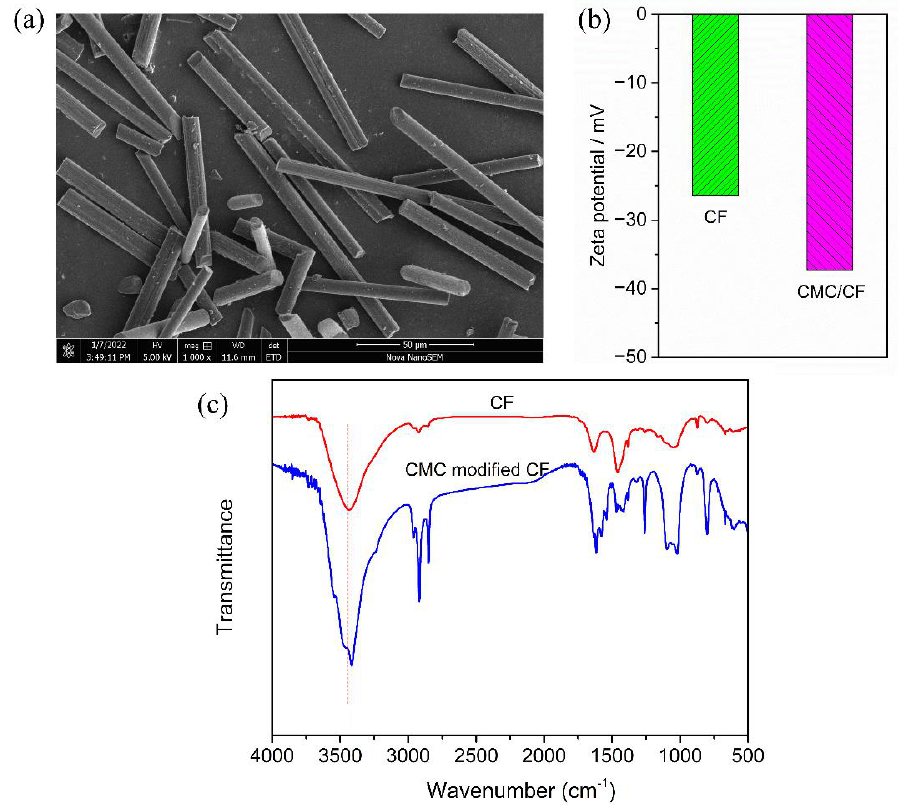
Figure 1. ( a ) SEM image of the CF, ( b ) Zeta potential of the CF and CMC/CF, ( c ) FTIR spectra of the CF and CMC/CF.